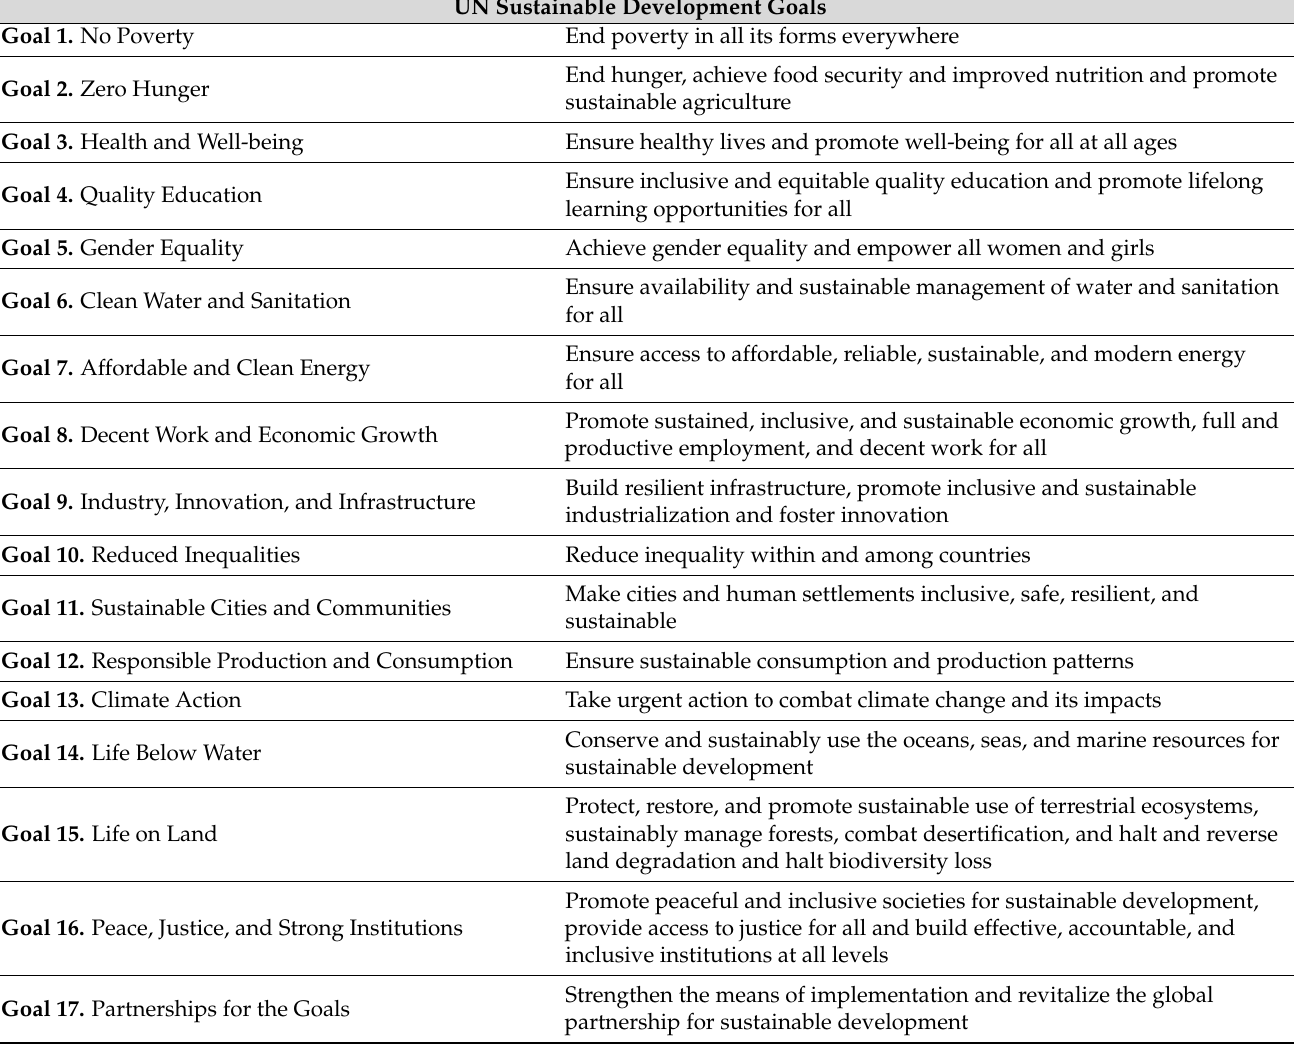
Table 1. The 17 UN Sustainable Development